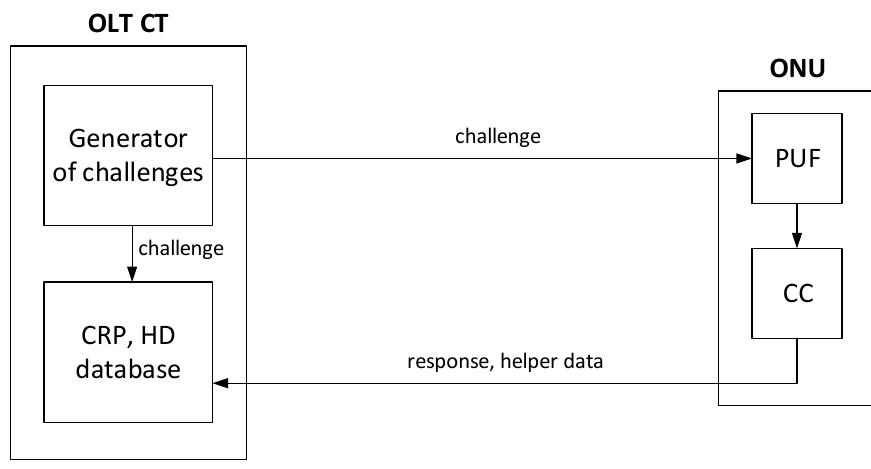
Figure 2. Initialization phase in SI-NG-PON2.